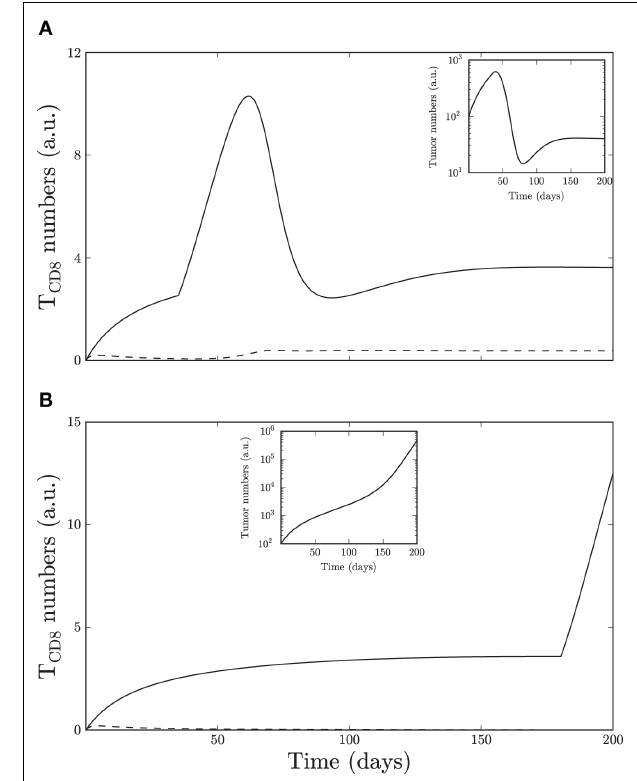
FIGURE 7 |The pancreatic tumor shown in Figure 6 is here modified ( b = 3.5, β = 100) and subjected to in silico site IV immunizations of equal strength on (A) day 35 and (B) day 180. Insets (A,B) show tumor cells on a log scale. Site I-specificT CD8 s is shown with a dashed line and